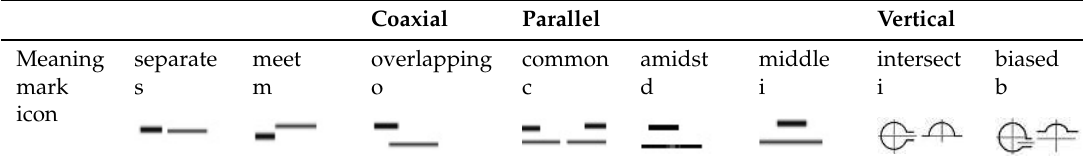
Table 1. Binary field relations between the functional surfaces.